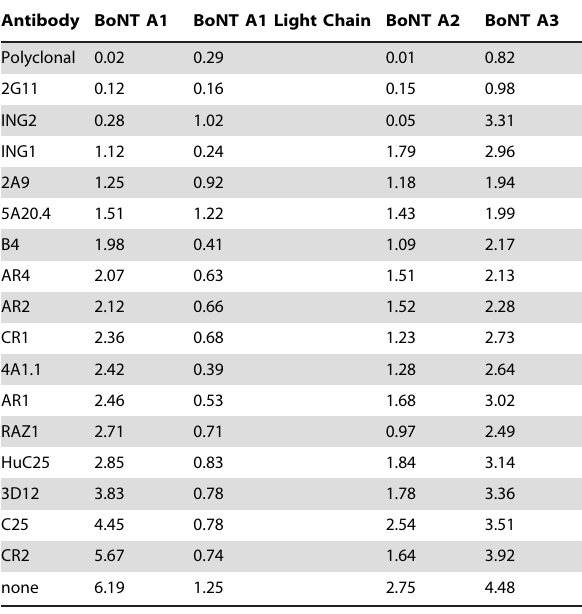
Table 2. Peak area ratios of the peptide cleavage product over the internal standard peptide obtained from the Endopep-MS reaction of BoNT/A with its peptide substrate in the presence of the antibody